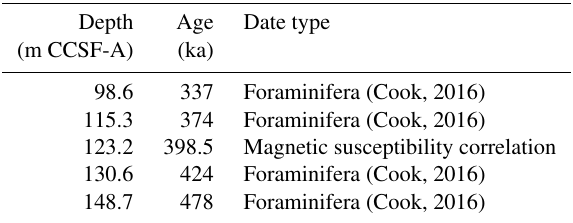
Table 1. Age–depth tie points used in the age model for U1345.